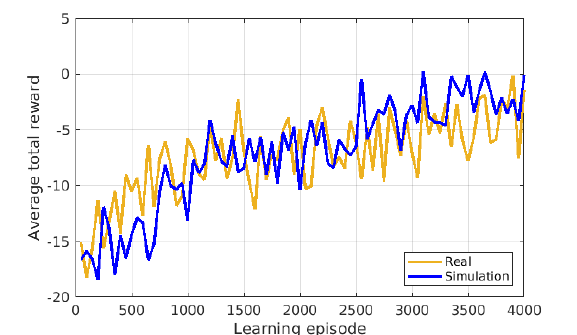
Figure 11: Learning curves of Deep ICAC for the vision-based leaning-to-grasp task on the simulated and real NICO